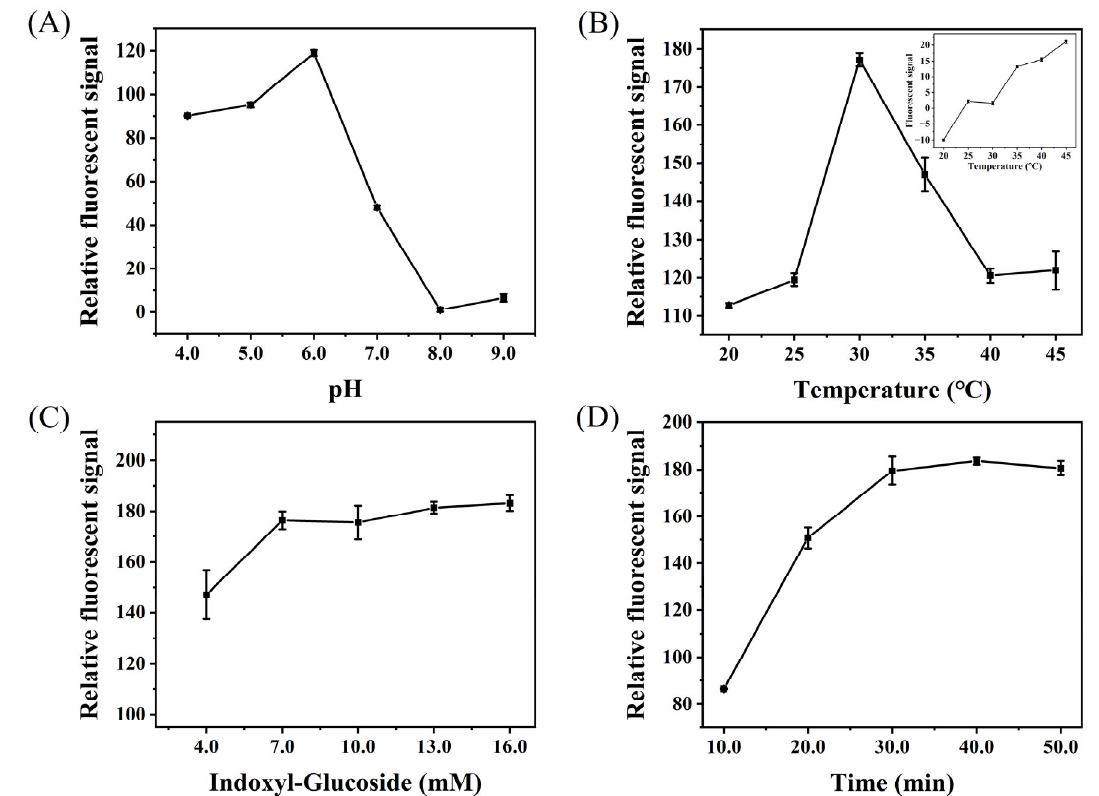
Figure 5. Effect of pH ( A ), temperature ( B ), indoxyl ‐ glucoside concentration ( C ), and reaction time Effect of pH ( A ), temperature ( B ), indoxyl-glucoside concentration ( C ), and re- ( D ) on the fluorescent detection of β‐ glucosidase by the paper ‐ based device, β‐ glucosidase = 1.0 action time ( D ) on the fluorescent detection of β -glucosidase by the paper-based device, U/mL. Inset: effect of temperature on the fluorescent detection of β‐ glucosidase by the paper ‐ based β -glucosidase = 1.0 U/mL. Inset: effect of temperature on the fluorescent detection of β -glucosidase device, β‐ glucosidase = 0.0 U/mL. by the paper-based device, β -glucosidase = 0.0